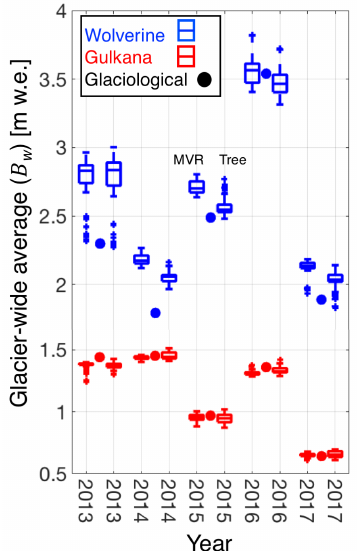
Figure 9. Comparing statistical models for GPR-derived glacier- wide winter balances for both Wolverine (blue) and Gulkana (red) glaciers. For each year and each glacier, two box plots are shown. The first shows multivariable regression model (MVR) output and the second shows regression tree output (tree). The B w estimate from the glaciological profile method is shown for each year and glacier as the filled circle.